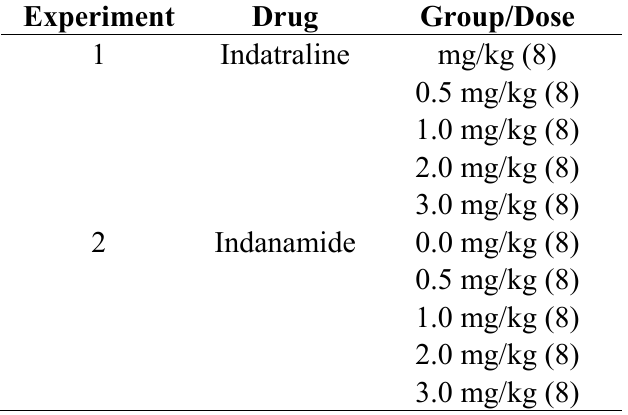
Table 2. Treatments for each group in Experiment 1 and Experiment